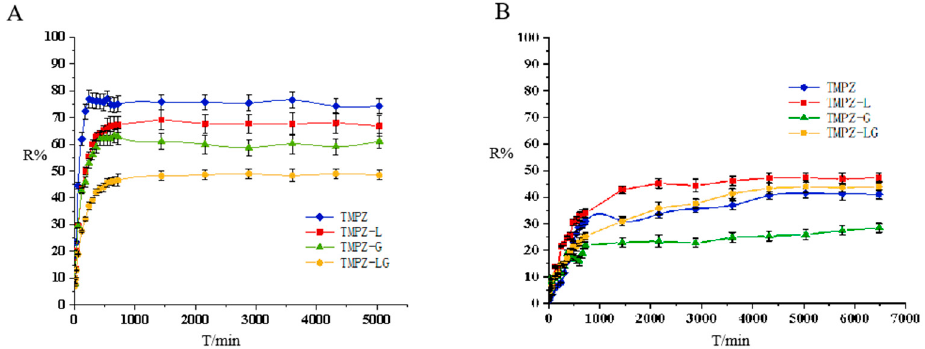
Figure 3. The release rate of TMPZ, TMPZ-L, TMPZ-G and TMPZ-LG. ( A ) Release rate across the dialysis membrane. ( B ) Transdermal release rate. dialysis membrane. ( B ) Transdermal release